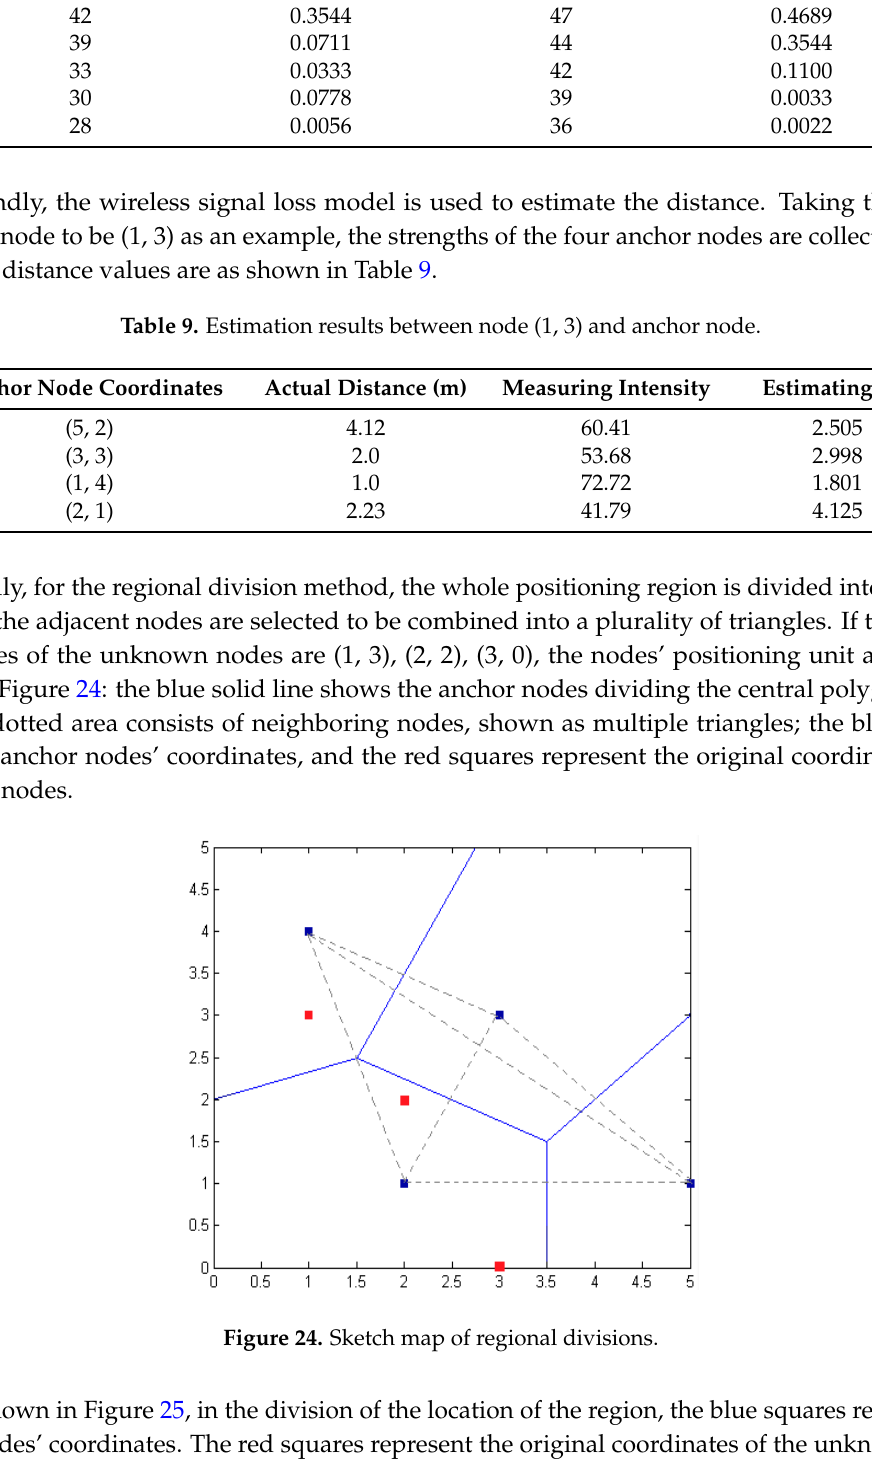
Figure 25. Node location map.